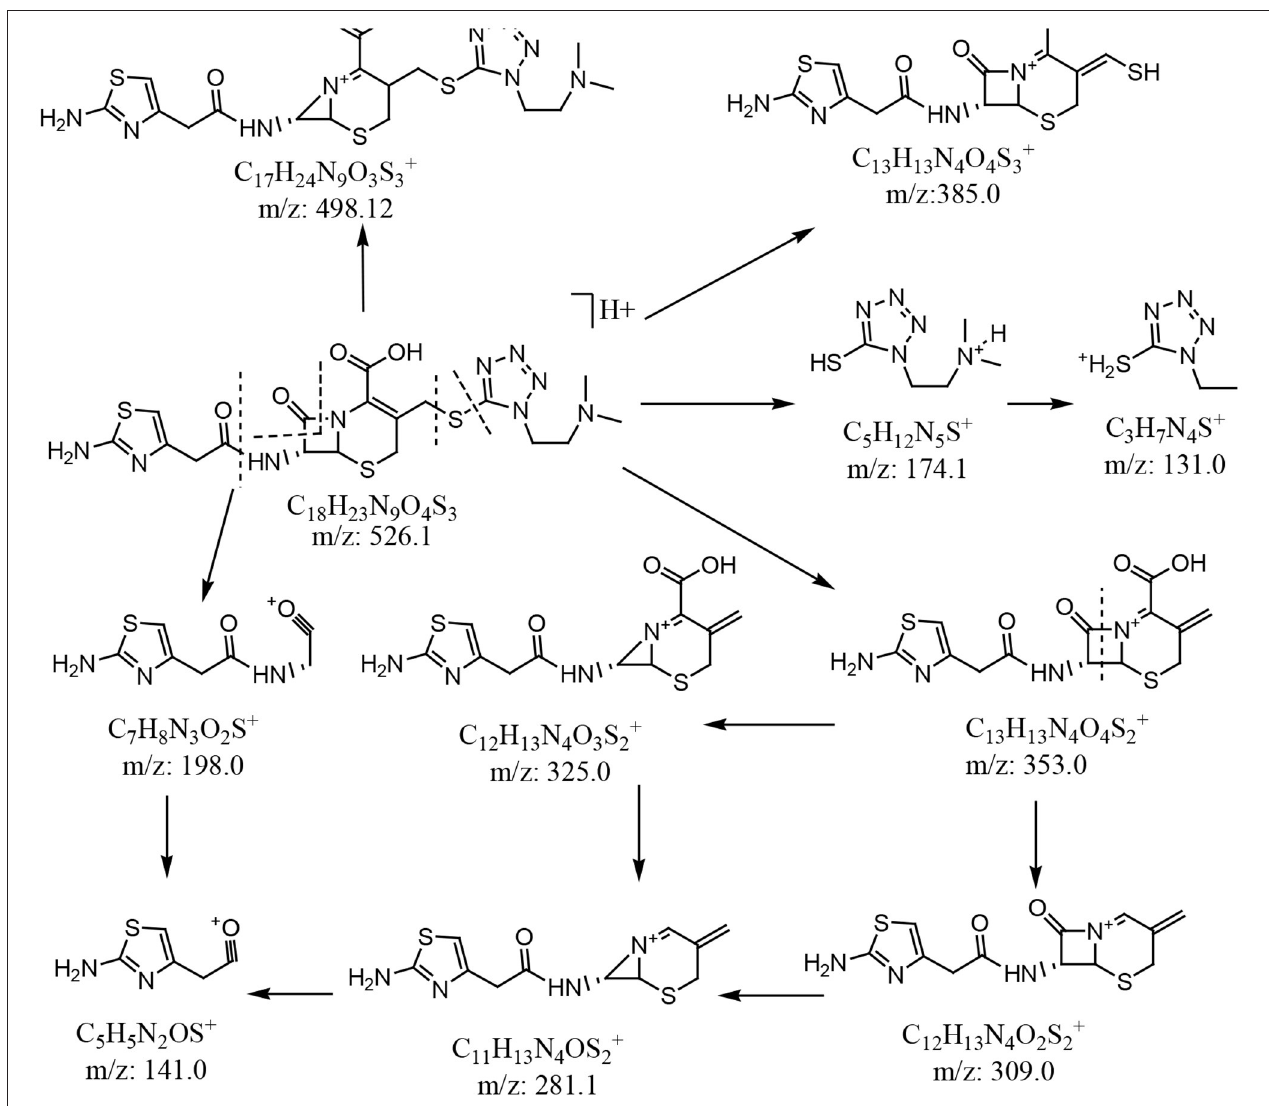
FIGURE 4 | Plausible MS fragmentation pattern for